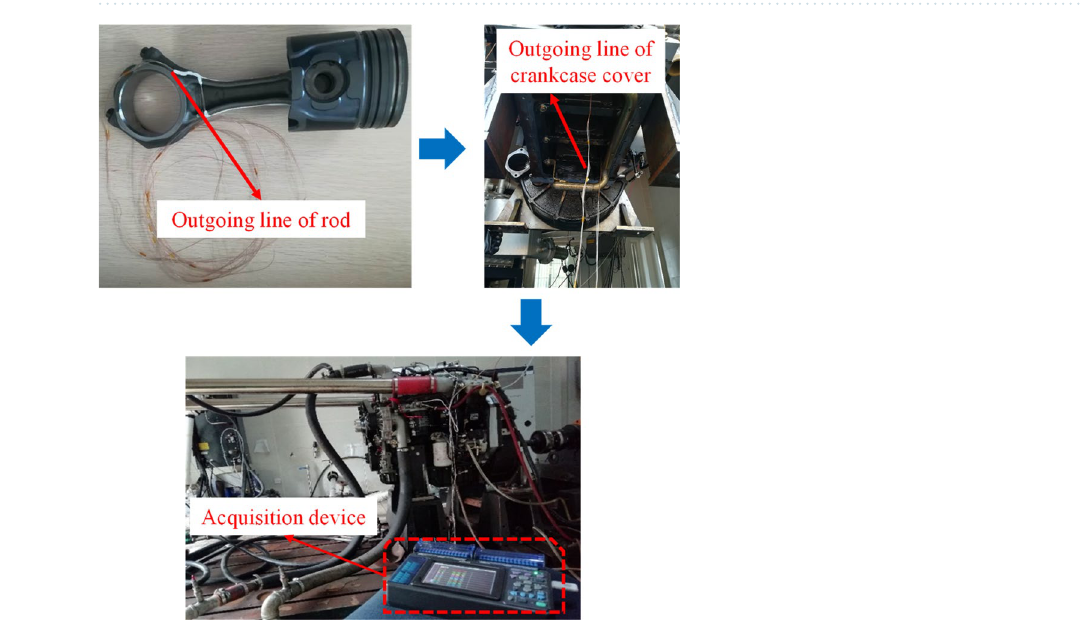
Figure 2. Lead physical diagram of thermocouple wire.